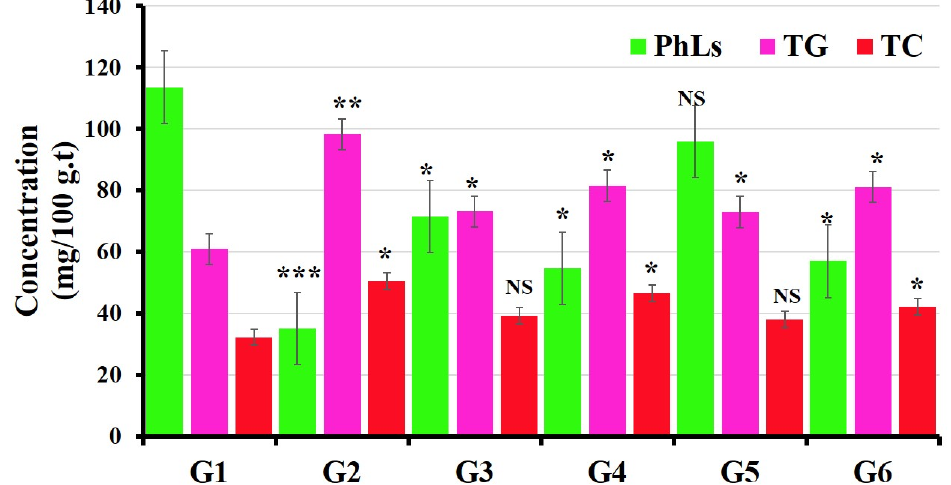
Figure 7. Effect of both Moringa and nano-Moringa leaf extracts on lipid profile in liver tissue homogenates of Bisphenol A—Exposed versus normal rats. G1: control. G2: BPA. G3: MOLE. G4: MOLE-BPA. G5: Encap. MOLE. G6: Encap. MOLE-BPA. The data are shown as * p < 0.05 ** p < 0.01 and *** p < 0.001.